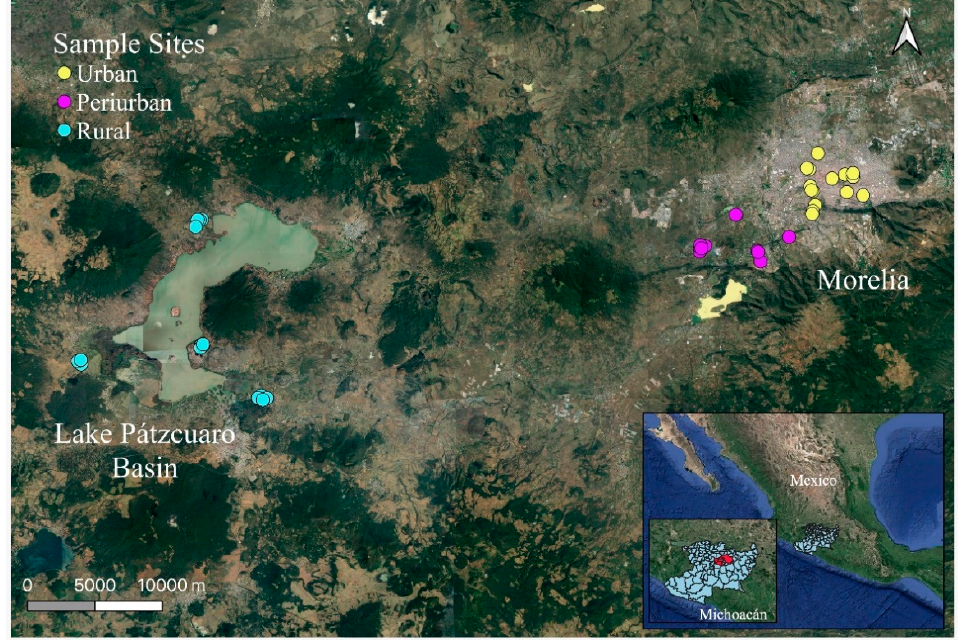
Figure 1. Map of the urban, peri-urban and rural areas of Morelia and the Lake Pátzcuaro Basin (LPB).